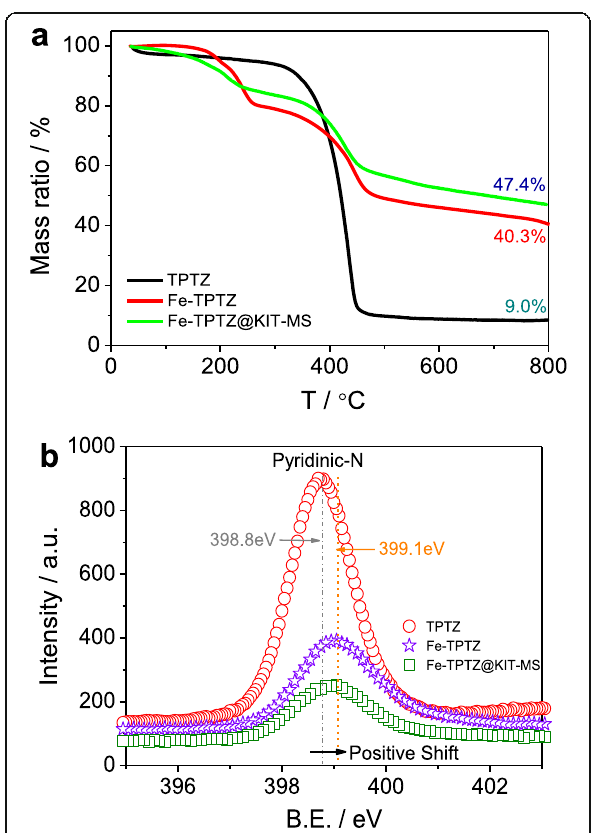
Fig. 2 a TGA curves and b high-resolution N1 s XPS spectra of TPTZ, Fe-TPTZ, and Fe-TPTZ@KIT-MS